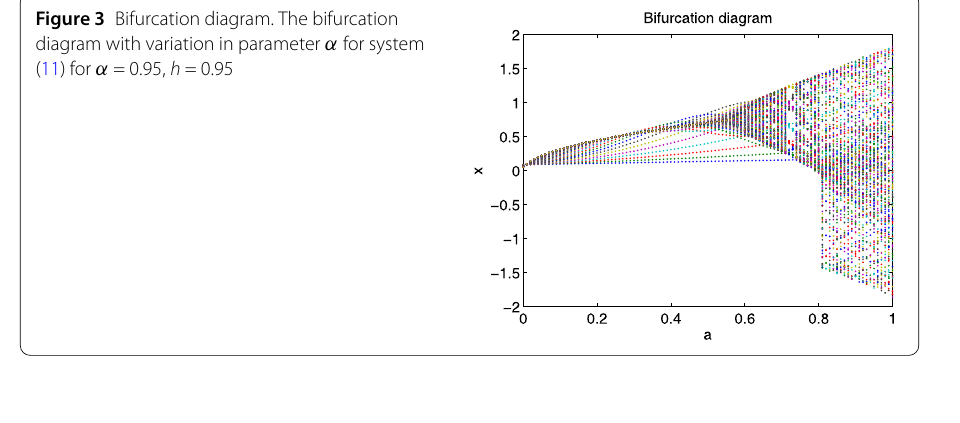
Figure 3 Bifurcation diagram. The bifurcation diagram with variation in parameter α for system (11) for α = 0.95, h = 0.95